Question: In one sentence, what is this figure communicating?
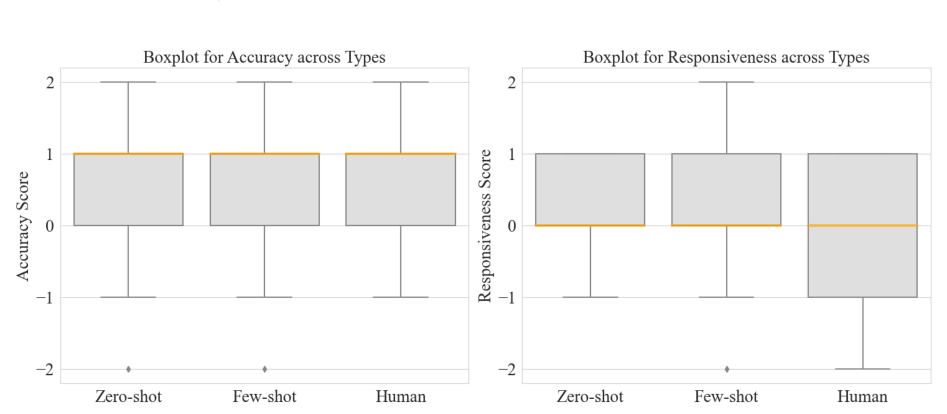
Answer: Distribution of accuracy and responsiveness scores from the lesson Determining What Students Know